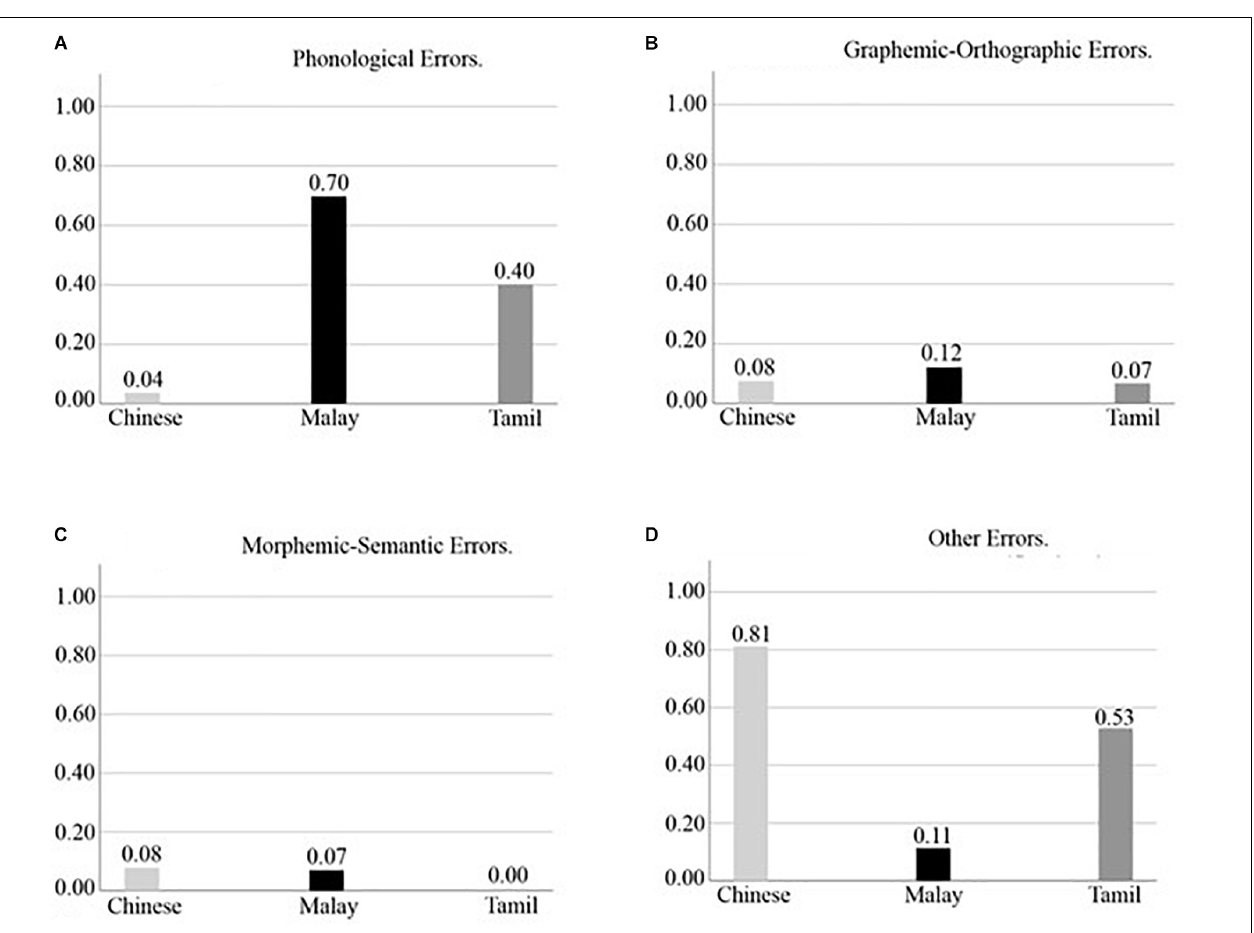
FIGURE 2 | Proportion of Phonological Errors (A) , Graphemic-Orthographic Errors (B) , Morphemic-Semantic Errors (C) , and Other Errors (D) in Chinese, Malay, and Tamil Asian language groups in subsample matched for SES ( N =